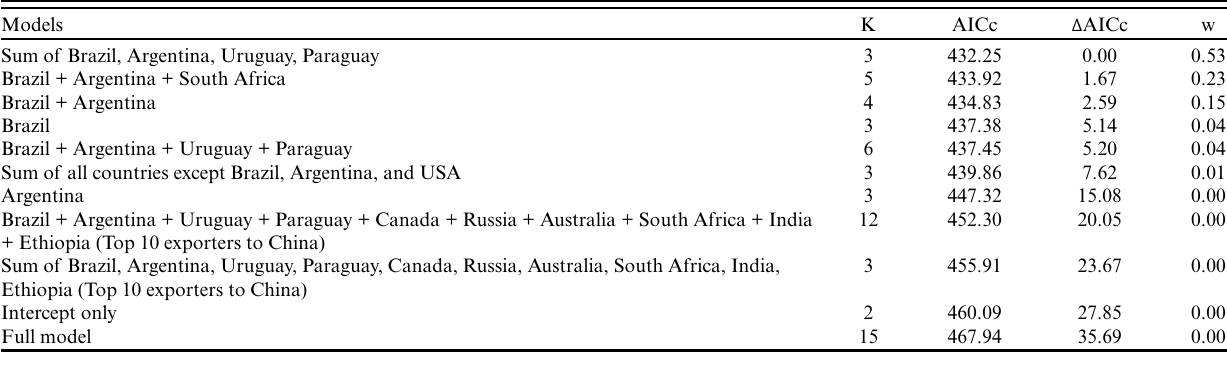
Table 2 . Results of model selection indicate how the USA’s betweenness, as an established soybean sending system, was affected by the value of soybean exported to China from other major sending countries. Models refers to the covariates for each of the models; K indicates the number of parameters in each model; AICc is the size-corrected Akaike Information Criterion (AICc; Akaike 1973, Burnham and Anderson 2002) that was used to rank models; Δ AICc is the difference between each model and the top model; w is the AICc weight of each model.